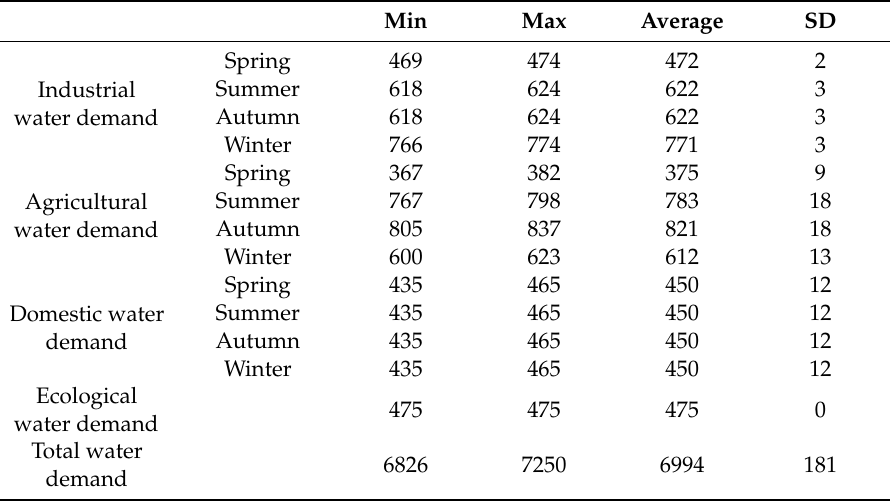
Table 3. Water demands in Shaanxi Province in 2050 among four scenarios (10 thousand m 3